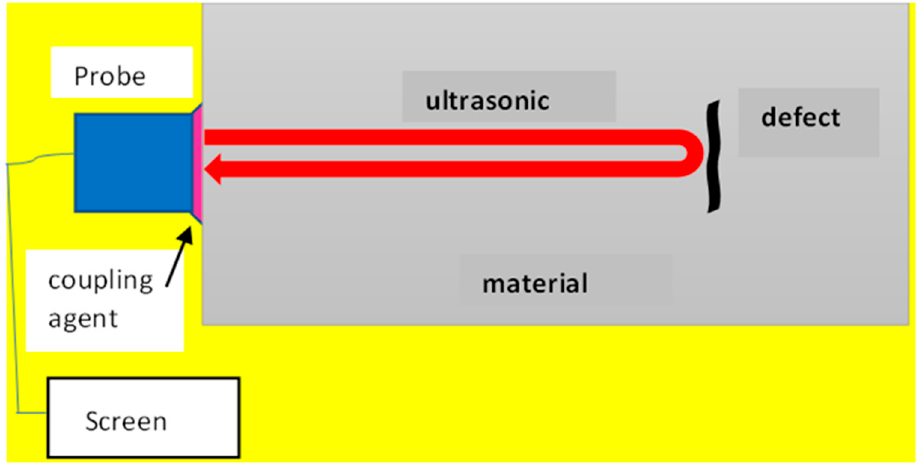
Figure 2. The basic setup of ultrasonic testing technique.